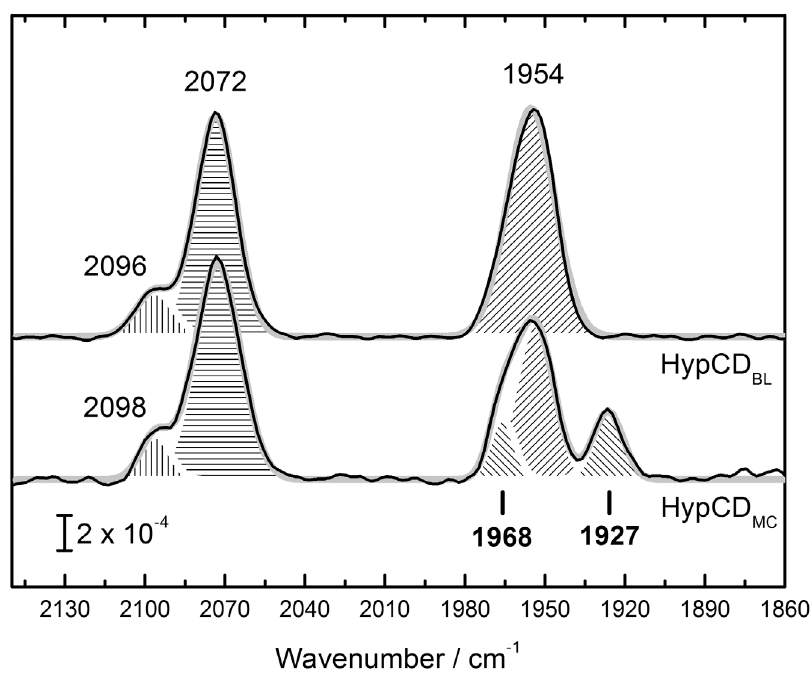
Figure 2. Comparison of the IR spectra of HypCD from E. coli strains BL21(DE3) and MC 4100. HypCD BL shows the characteristic signature [17,18] of one CO (1954 cm 2 1 , diagonal hatch) and two CN 2 ligands (2072, 2096 cm 2 1 , straight hatch). HypCD MC has a novel contribution in the CO region (1927 cm 2 1 ) and shows a shoulder blue–shifted to the CO peak at 1954 cm 2 1 . The latter shoulder fits best to a Gaussian peak with a center wavenumber of 1968 cm 2 1 . The bold gray line in the background represents an overall fit of the spectrum.